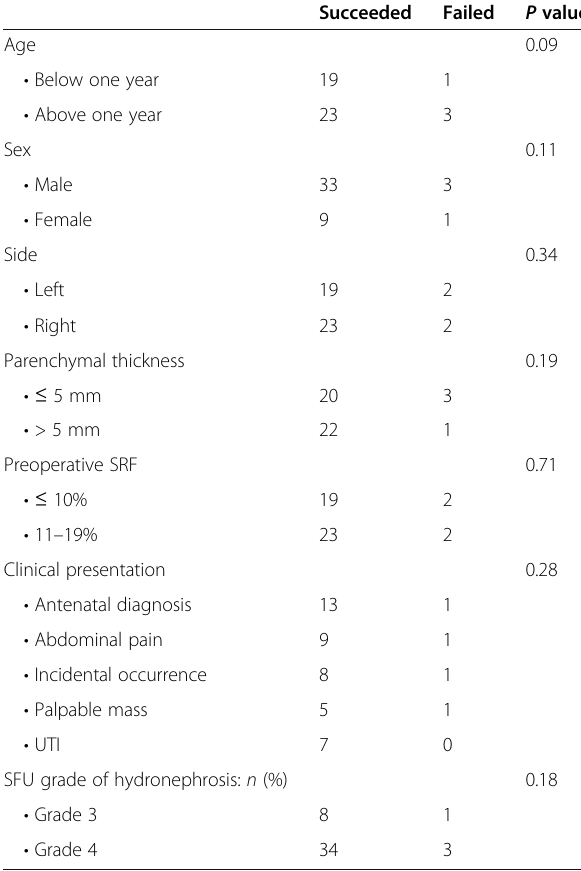
Table 3 Univariate analysis of preoperative factors in relation to the outcome of pyeloplasty